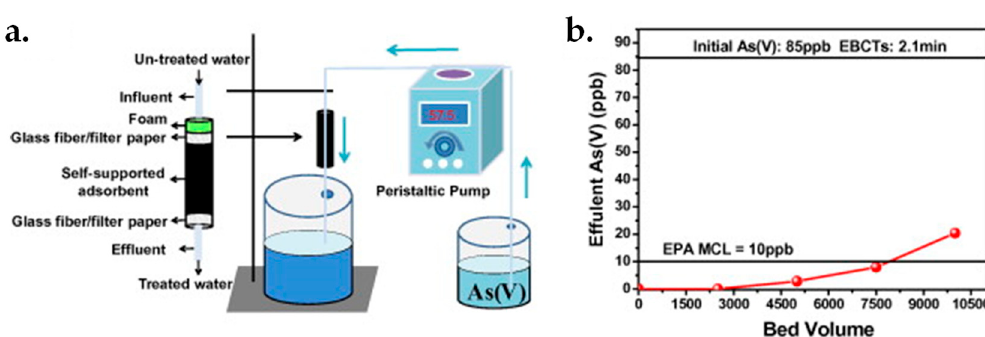
Figure 5. ( a ) Scheme of the As 5+ removal from water by using Fe 2 O 3 /rGO hybrids as the filter. ( b ) Relations between bed volume and remaining effluent As 5+ in wastewater. Reproduced from [164], with permission from Elsevier, 2014.